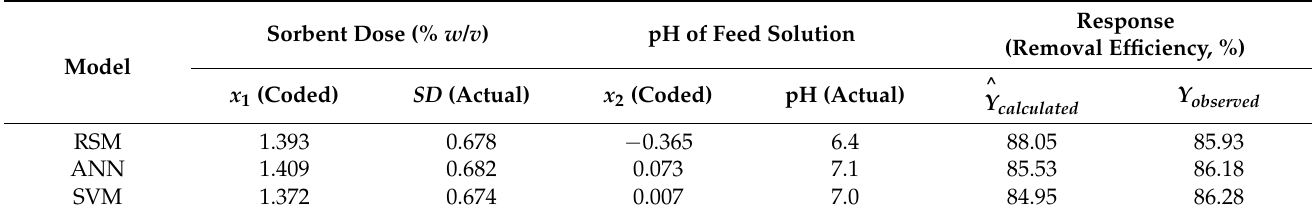
Table 3. Optimal points established by model-based numerical optimization and confirmation